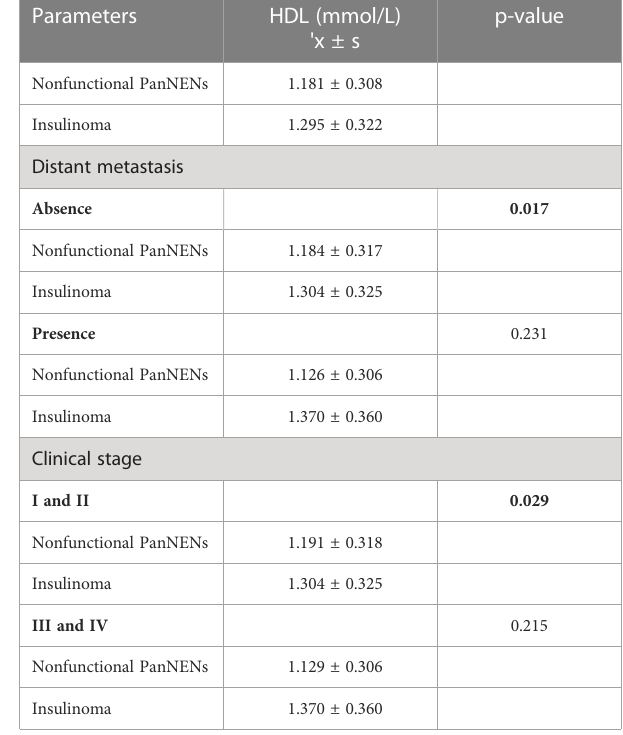
TABLE 5 Comparison of HDL levels in PanNENs with different clinicopathological